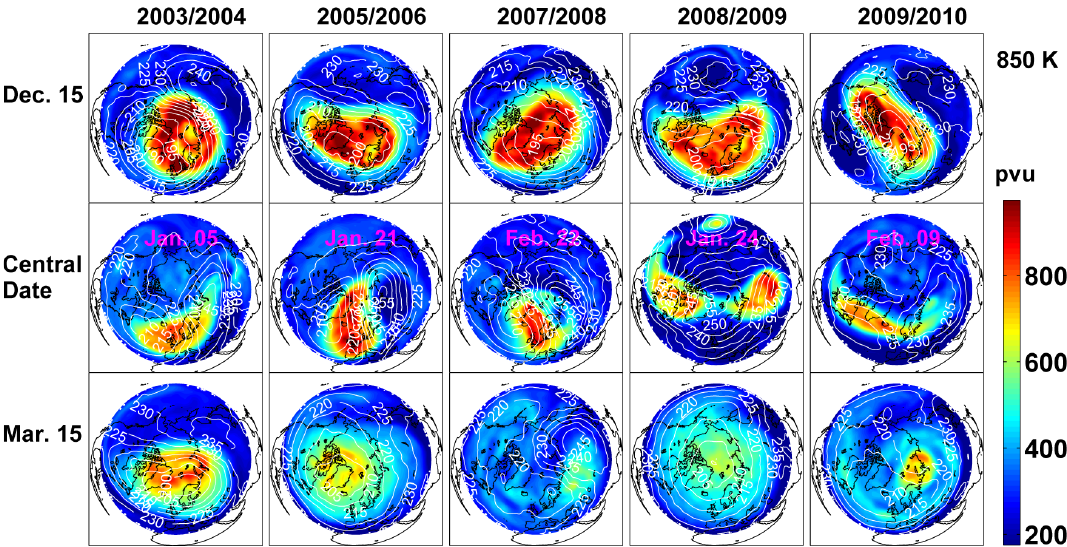
Fig. 4. Maps of potential vorticity (data: the ECMWF operational analysis) at 850K ( ∼ 10hPa/30km) for various Arctic winters on 15 December, 15 March and on the central date, the day on which the westerlies changed to easterlies at 60 ◦ N/10hPa. The overlaid white contours show temperature in